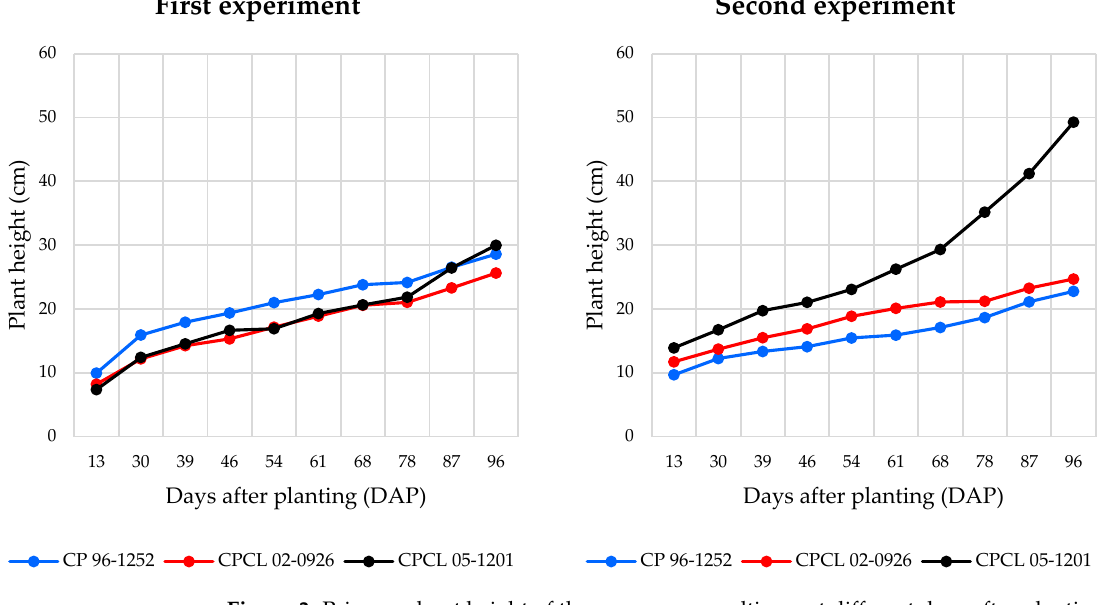
Figure 3. Primary shoot height of three sugarcane cultivars at different days after planting in the first and second greenhouse experiment.